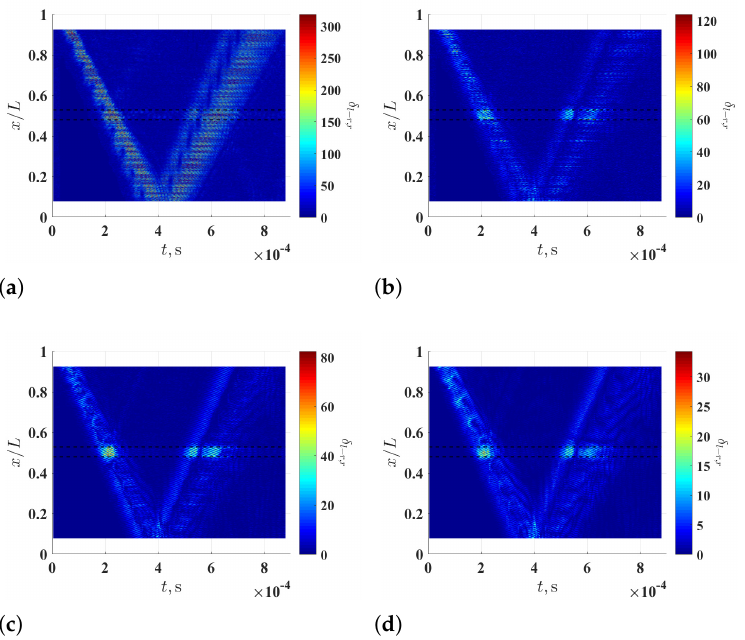
Figure 11. Multi-resolution local-regression TSCDI δ l − r , r associated with the measured wave of the damaged beam with ( a ) r = 1, ( b ) r = 8, ( c ) r = 16 and ( d ) r = 32 and ξ = 15%. Locality and extent of the damage are indicated by two dashed